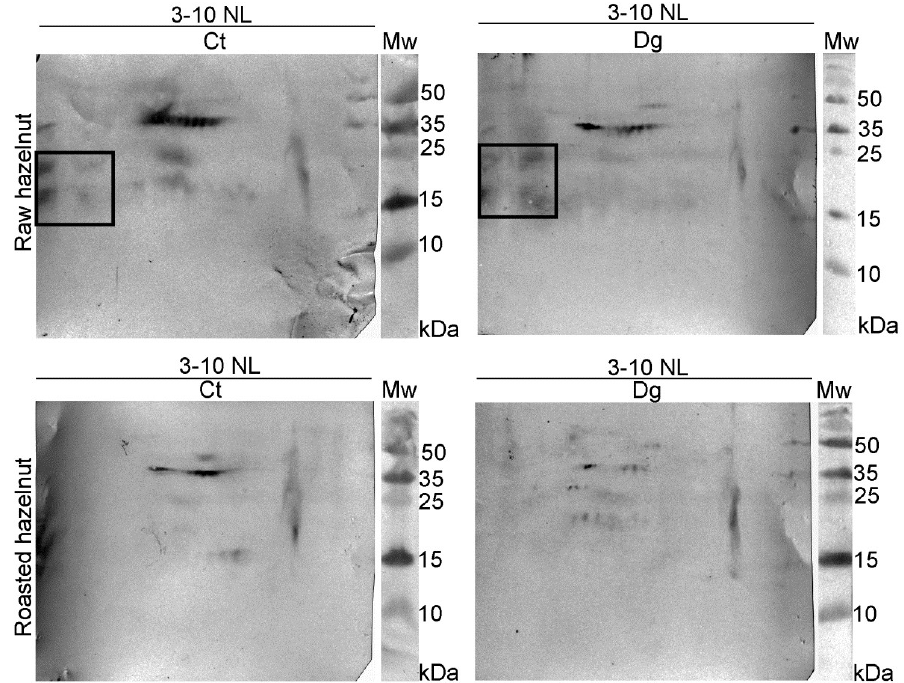
Figure 3. 2D immunoblots probed with the pool of hazelnut-allergic patients’ sera on resolved non-defatted raw and roasted hazelnut gastric digesta and their respective controls in reducing conditions; Ct—control sample, Dg—gastric phase; Mw—molecular weight markers; kDa—Kilo Daltons; 3–10 NL—nonlinear pH range 3–10.